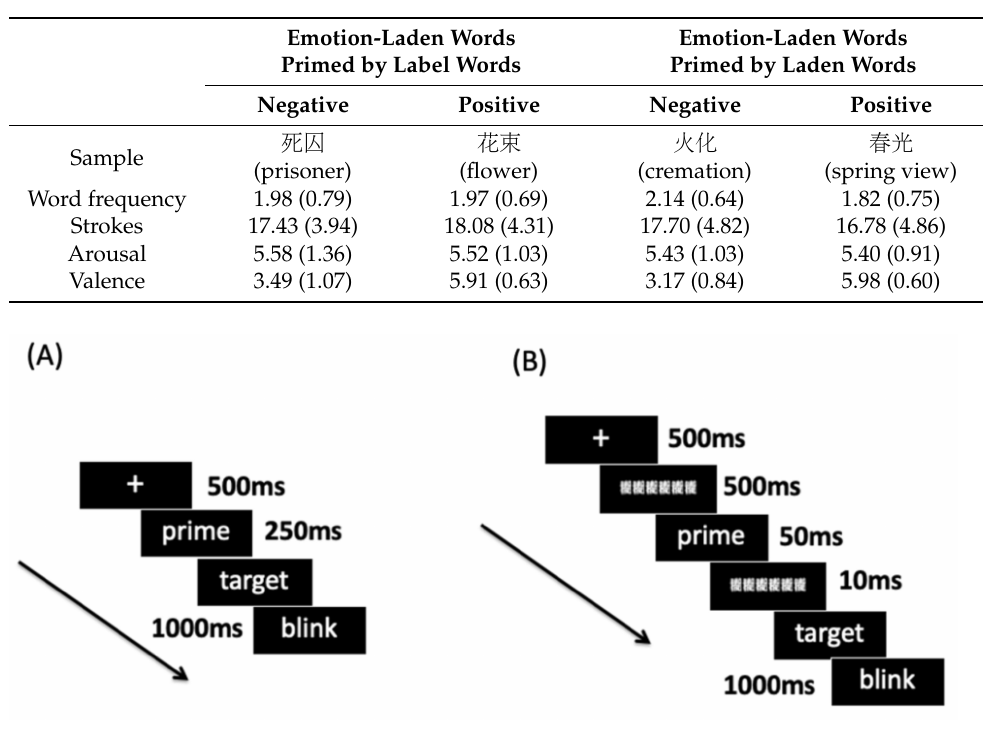
Table 2. Mean and standard deviation (SD) in brackets for word characteristics for Chinese emotion- laden words as targets.